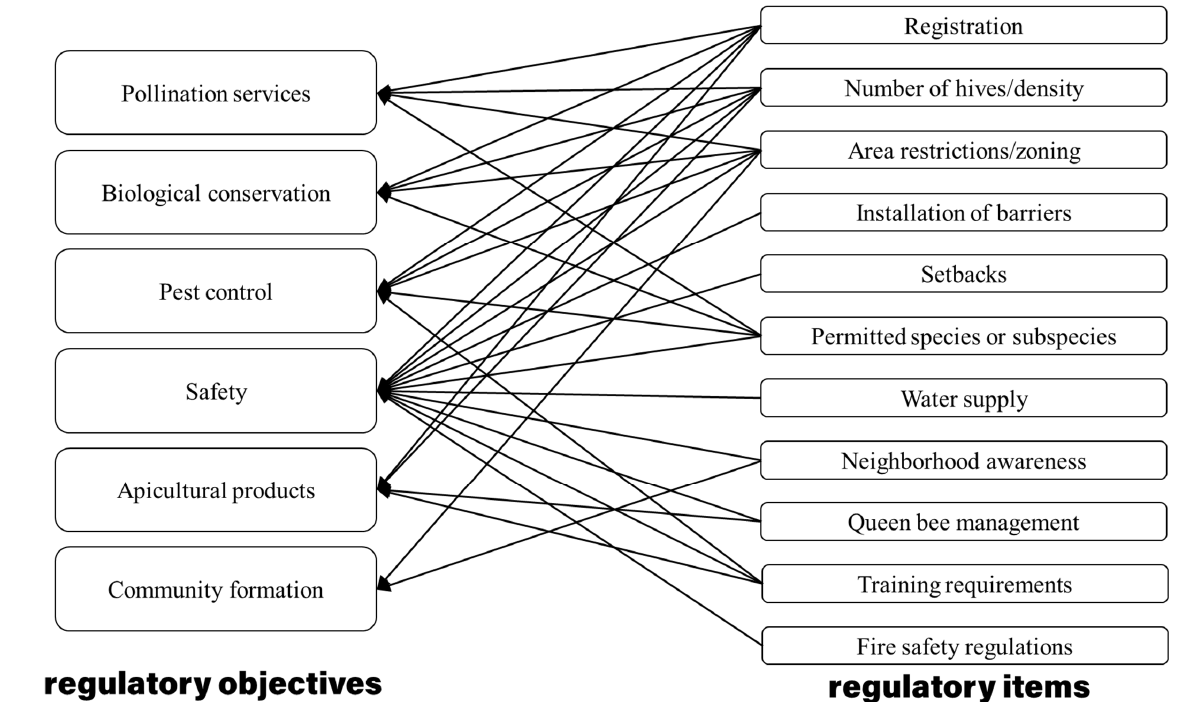
Figure 1. Relationships among regulatory objectives and items for urban beekeeping.